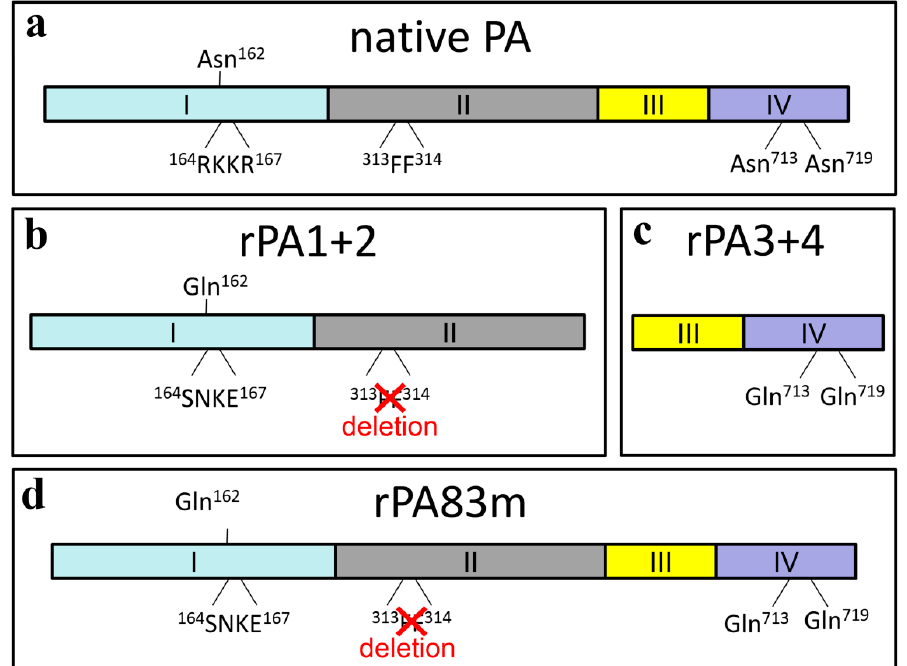
Figure 2. Graphical overview of modified recombinant anthrax antigens rPA1+2 ( b ), rPA3+4 ( c ) and rPA83m ( d ) compared with native PA ( a ). rPA1+2 contains PA domains I and II with mutations at furin and chymotrypsin cleavage sites (the 162 NSRKKR 167 fragment was replaced by 162 QSSNKE 167 at the furin proteolysis site and the 313 FF 314 fragment was deleted at the chymotrypsin proteolysis site). rPA3+4 contains PA domains III and IV with deamidation-prone Asn 713 and Asn 719 residues both replaced with Gln. rPA83m is a full-size modified recombinant PA with all modifications implemented in rPA1+2 and rPA3+4.